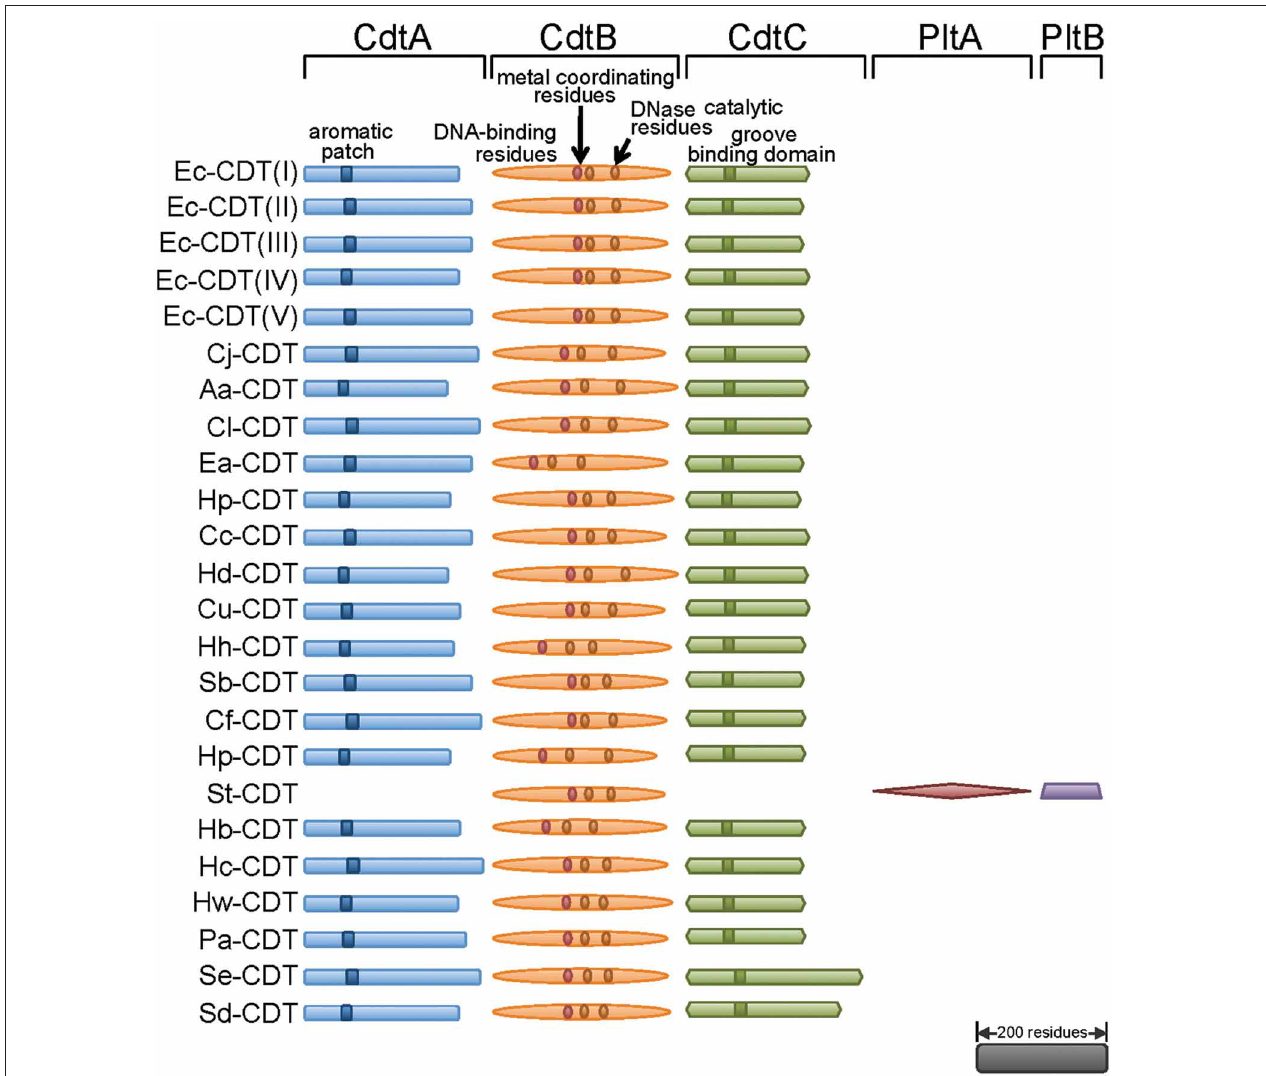
FIGURE 1 | Three independent proteins are required to make CDT holotoxin. Most of the known CDTs are composed of CdtA, CdtB, and CdtC, with some exceptions like S. typhi where PltA and PltB make holotoxin with CdtB. All CdtAs contain an aromatic patch, demonstrated to be important in binding to the surface of mammalian cells. CdtBs are most conserved amongst three proteins, and are the catalytic subunit of the toxin carrying conserved metal coordinating residues, DNase catalytic residues, and residues homologousto DNA contacting residues of DNase I. CdtCs contain conserved residues believed to be important in formation of a cell surface binding groove. The scale bar represents primary sequence length equivalent